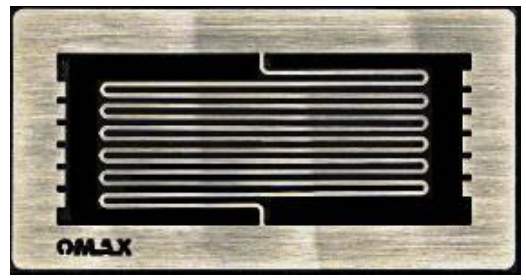
Figure 3. Stainless steel flexure - MicroMAX.